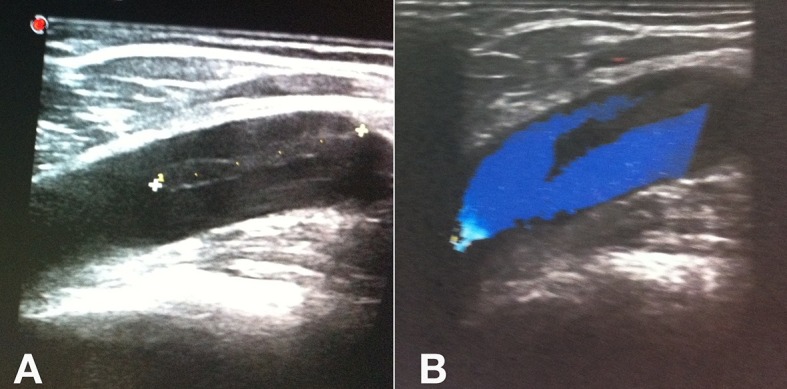
Endovenous heat-induced thrombosis with thrombus with a floating appearance and extension of less than 50% of the lumen of the common femoral vein. (A) Mode B ultrasound image; (B) Color mode ultrasound image.